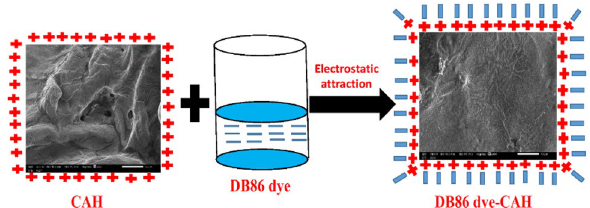
Figure 14. DB86 dye absorption mechanism on CAH.